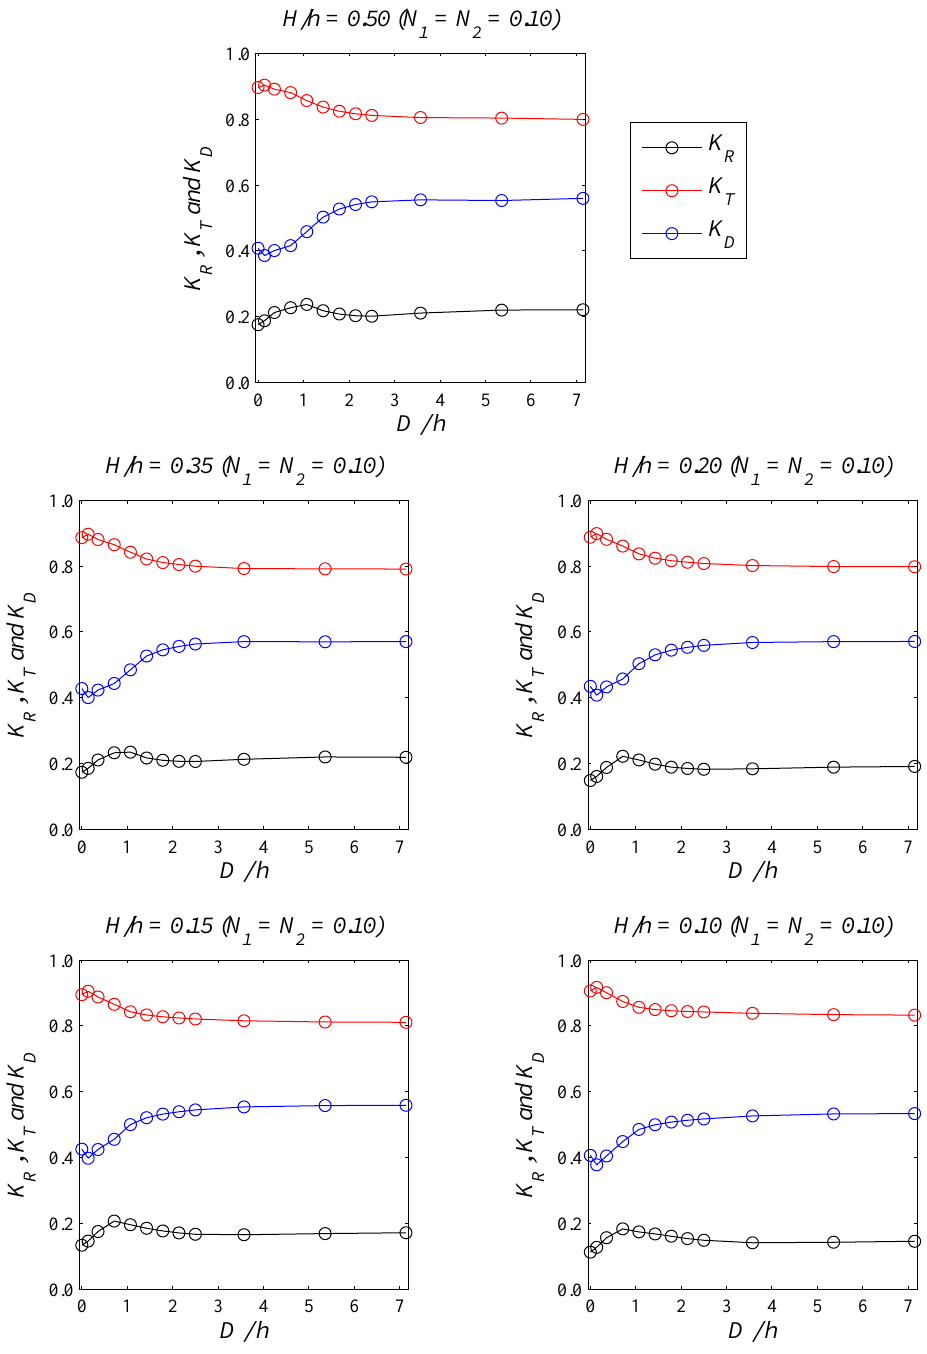
Figure 9. Effects of the horizontal distance ( D ) between two slotted barriers on the energy reflection ( K R ), transmission ( K T ) and dissipation ( K D ) coefficients, for the cases of H / h = 0.50, 0.35, 0.20, 0.15 and 0.10.